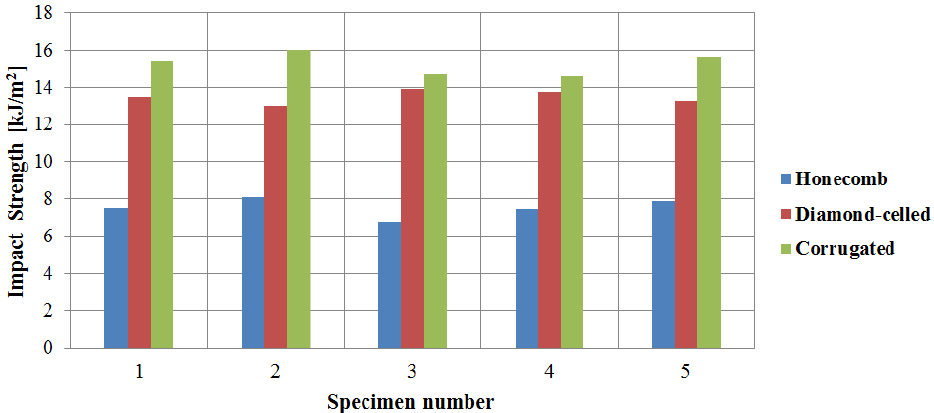
Figure 18. Charpy impact strengths of the wing leading edges specimens.